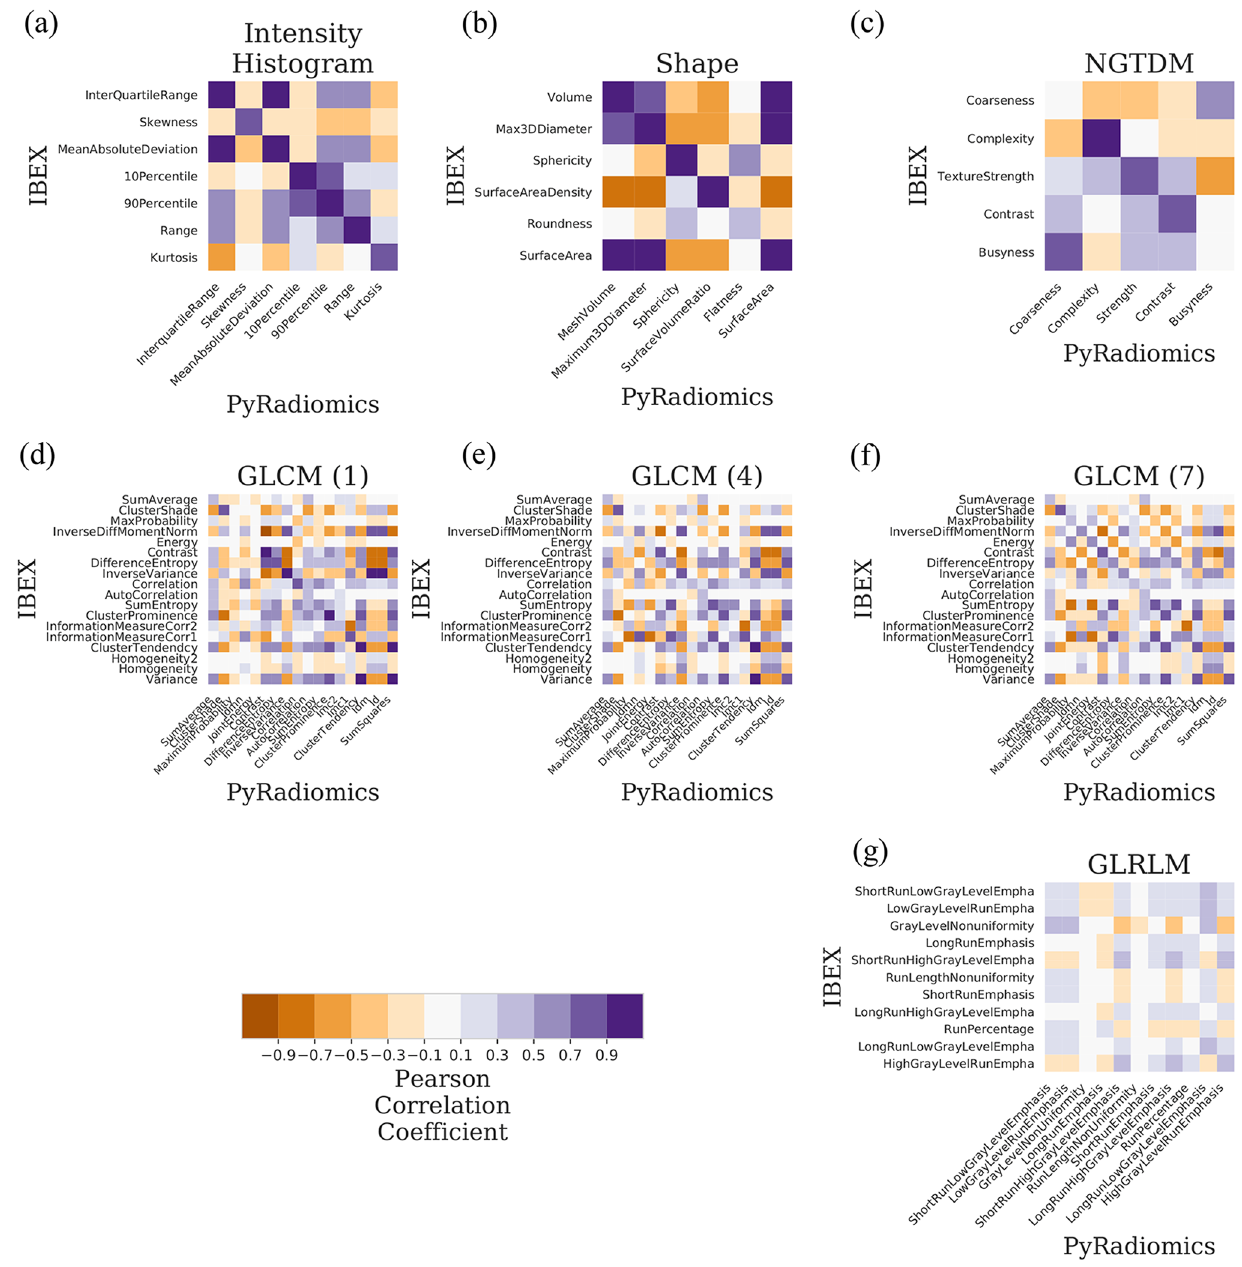
Figure 1. Apparent diffusion coefficient (ADC) maps of a head and neck cancer patient throughout radiotherapy from the PREDICT-HN prospective clinical trial. ( a ) ADC maps are displayed with (top row) the gross tumour volume (GTV) highlighted in colour and (middle row) cropped to the GTV to focus on the region of interest for the radiomic analysis. Change in ( b ) the ADC histogram within the GTV is from baseline (TP0), weekly throughout radiotherapy (TP1–TP6) and post-radiotherapy (TP7) with the histogram colour matched to the GTV contour